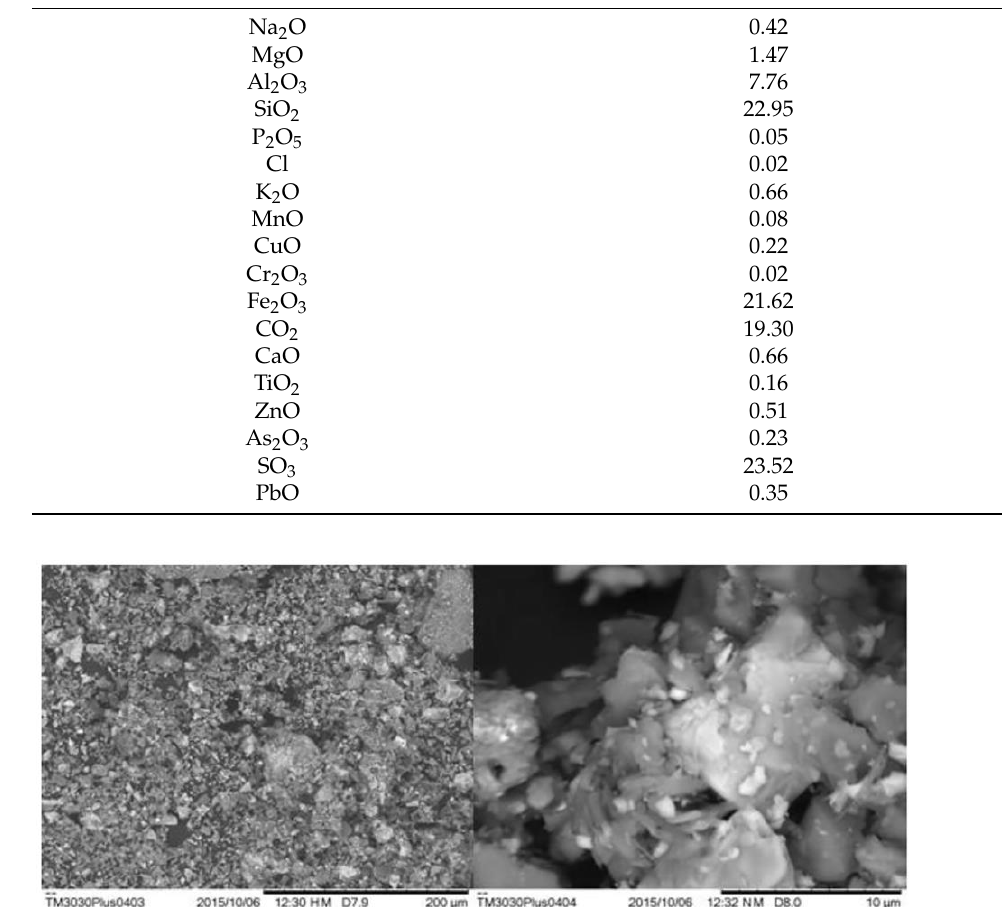
Figure 4. Microstructure of the mine tailing obtained through SEM by Coelho (2016) [27]. Table 1. Chemical composition of the mine tailing obtained by XRF.